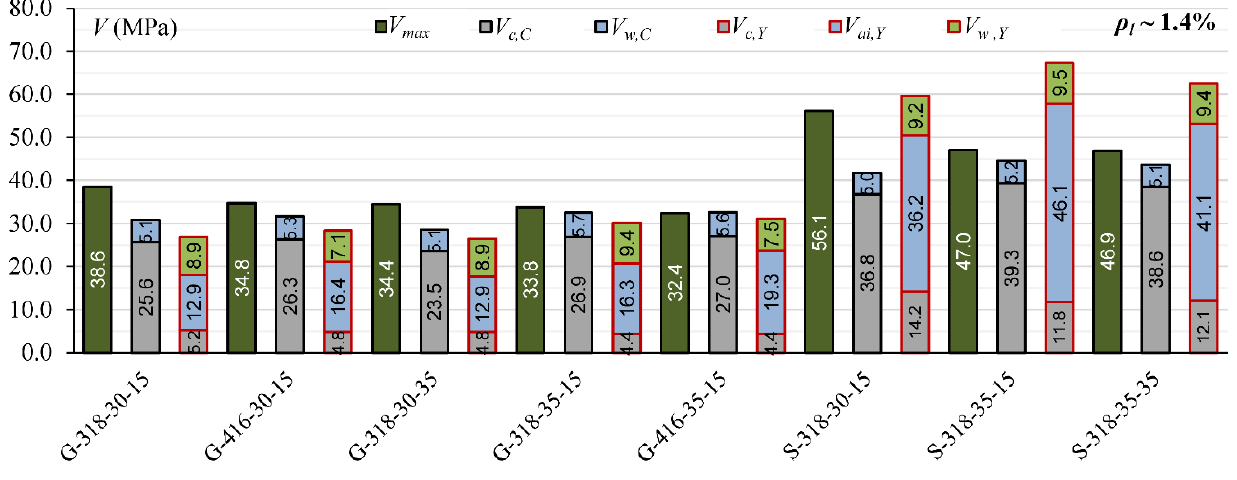
Figure 10. The comparison of shear mechanism contribution for GFRP and steel RC beams with reinforcement ratio ρ l ~ 1.4% for Cladera et al.’s and Yang’s models.